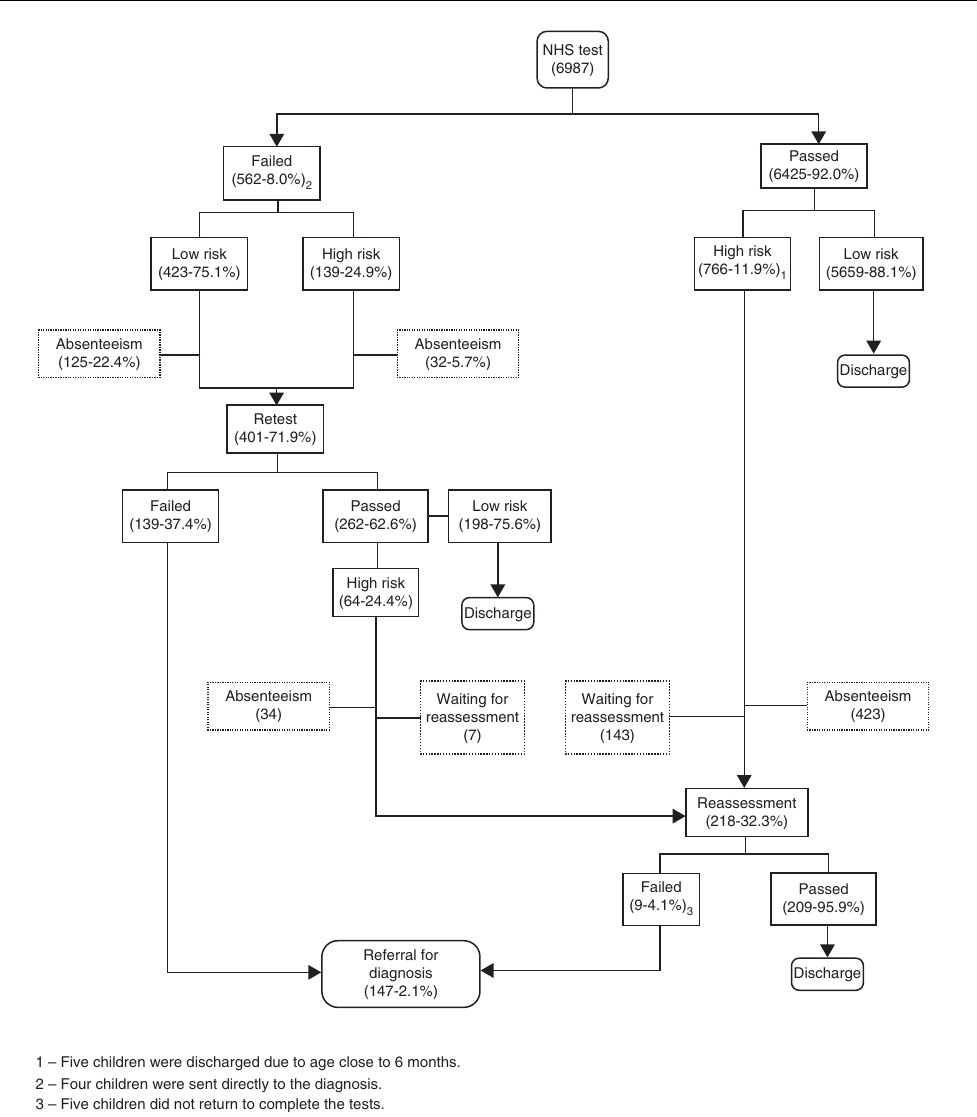
Figure 1 Assistance trajectory of children evaluated by a newborn hearing screening service in the city of Belo Horizonte, 2010---2011. Phase 1: NHS